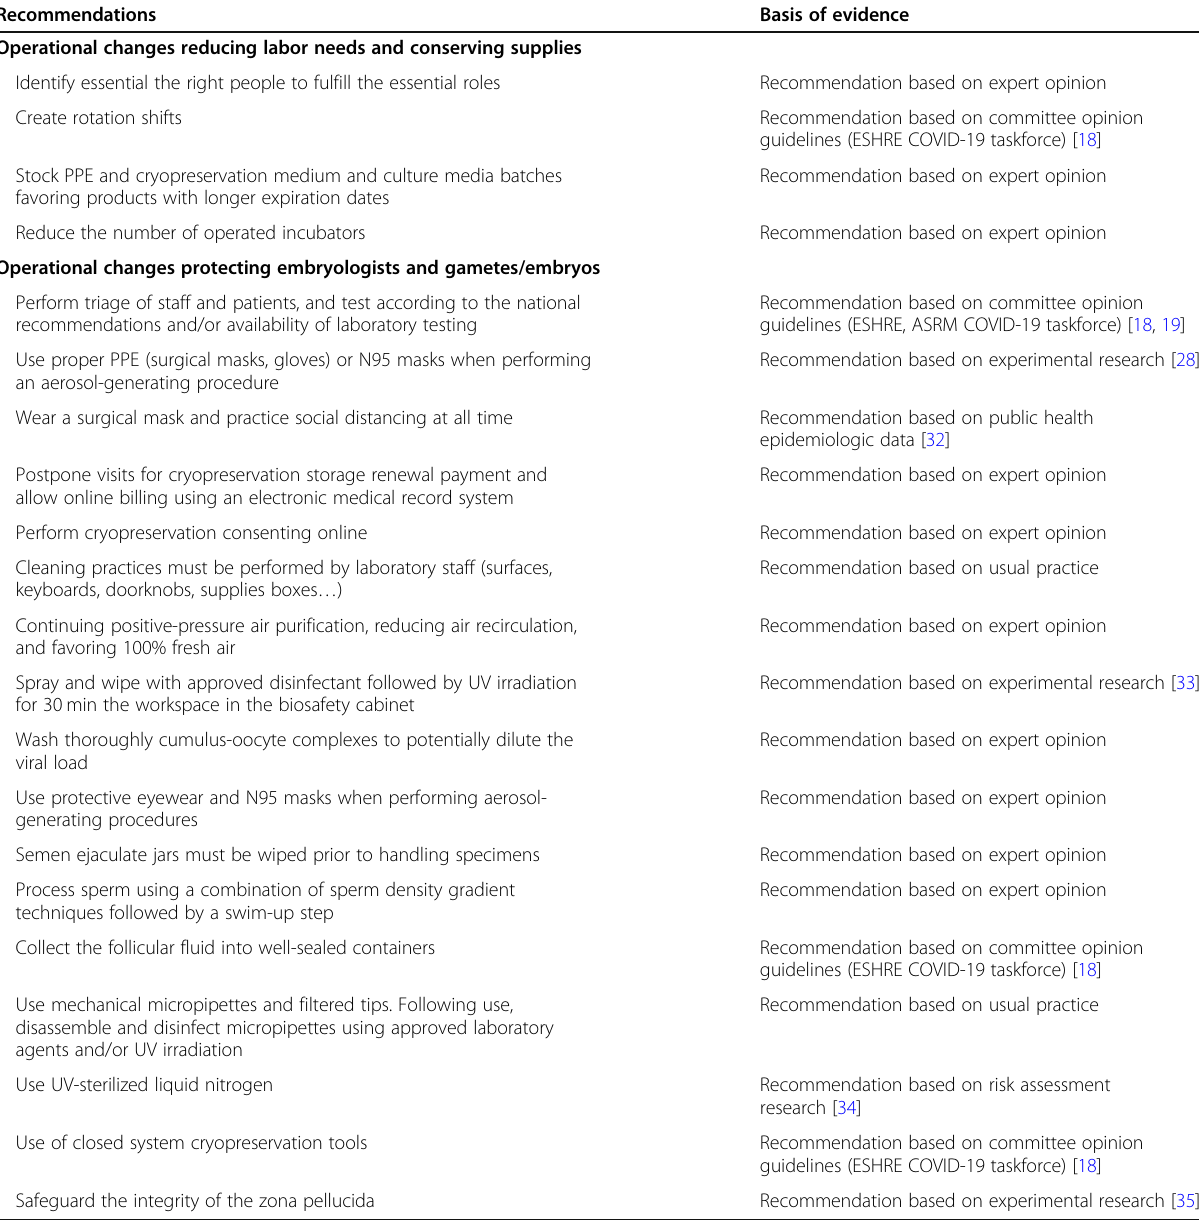
Table 2 Pandemic response plan: recommendations for embryology and andrology laboratories during the coronavirus pandemic Recommendations Operational changes reducing labor needs and conserving supplies Identify essential the right people to fulfill the essential